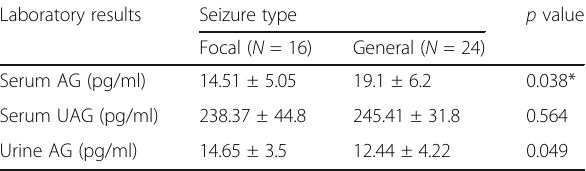
Table 2 Relation between laboratory results and seizure type Laboratory results